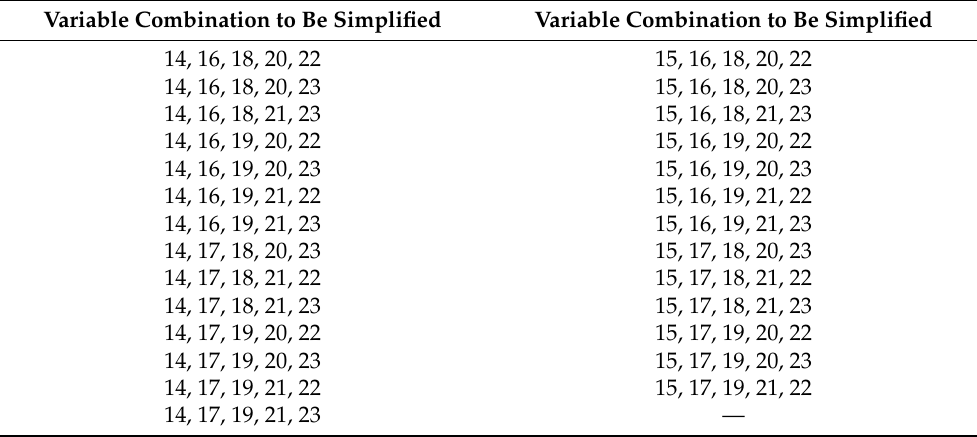
Table 3. Available simplification plan with 5 fast variables for the proposed method. Variable Combination to Be Simplified